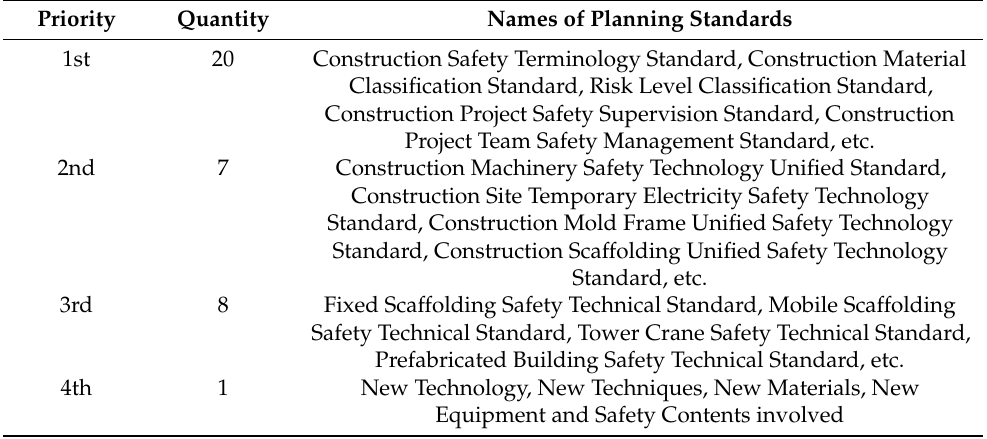
Table 4. Construction safety standard